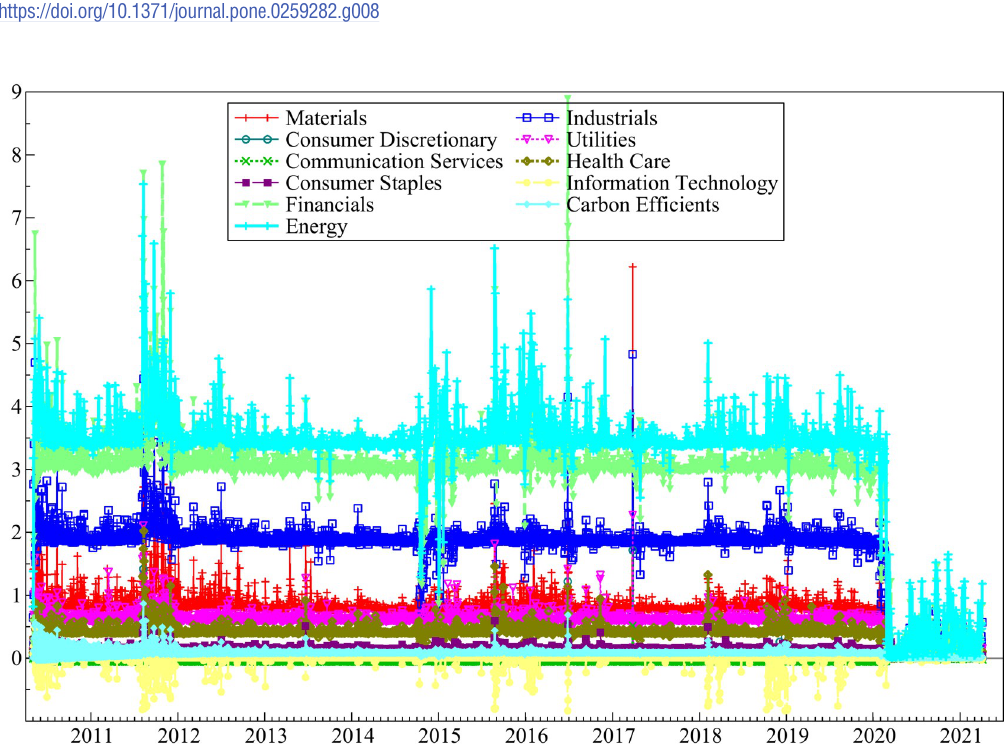
Fig 9. Effectiveness of optimal weights strategy. Dynamic effectiveness of diversifying IEMV with each sectoral indices (https://ndownloader.figshare.com/files/29099883).